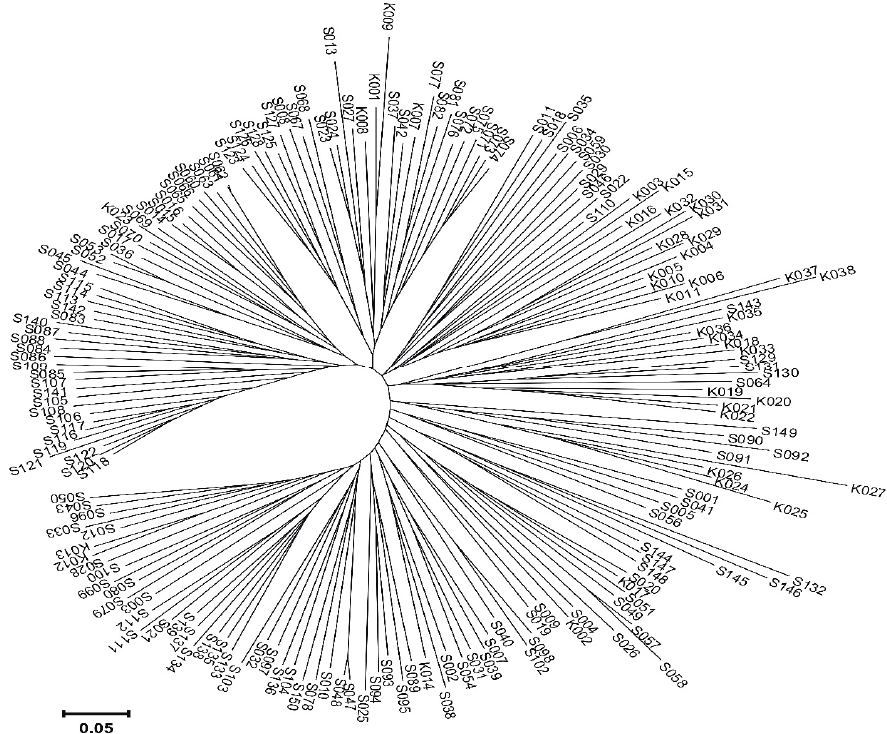
Figure 1. Dendrogram of genetic similarity between the analyzed lines, determined based on the identified molecular markers SilicoDArT and SNP.